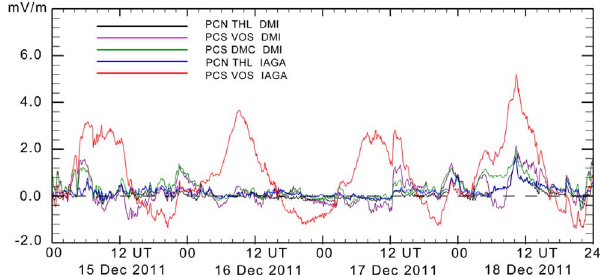
Fig. 16. Display of published PCN (blue line) and PCS (red) values from 15th to 18th December 2011. PCN values (black) from Qaanaaq data, PCS from Vostok (magenta) and Dome-C (green) data derived by a different method (DMI, Stauning, 2016) have been added to the diagram (Stauning,